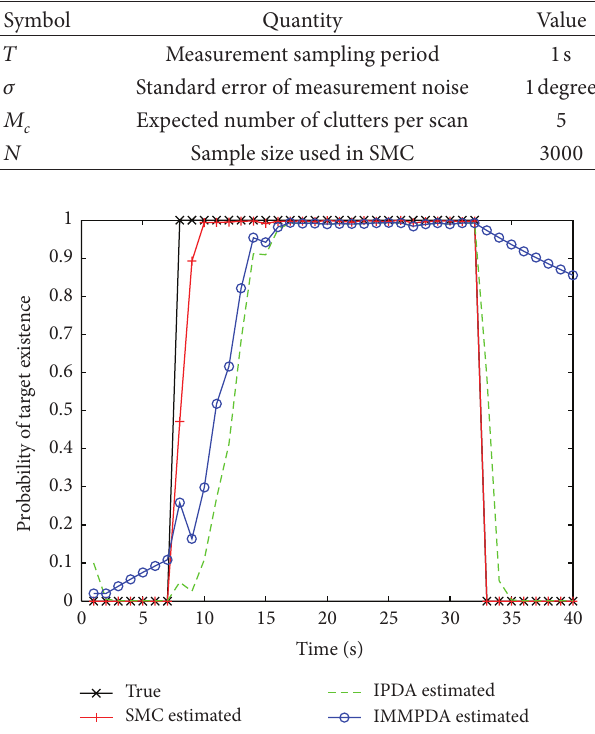
Table 1: Parameter setting for simulation.